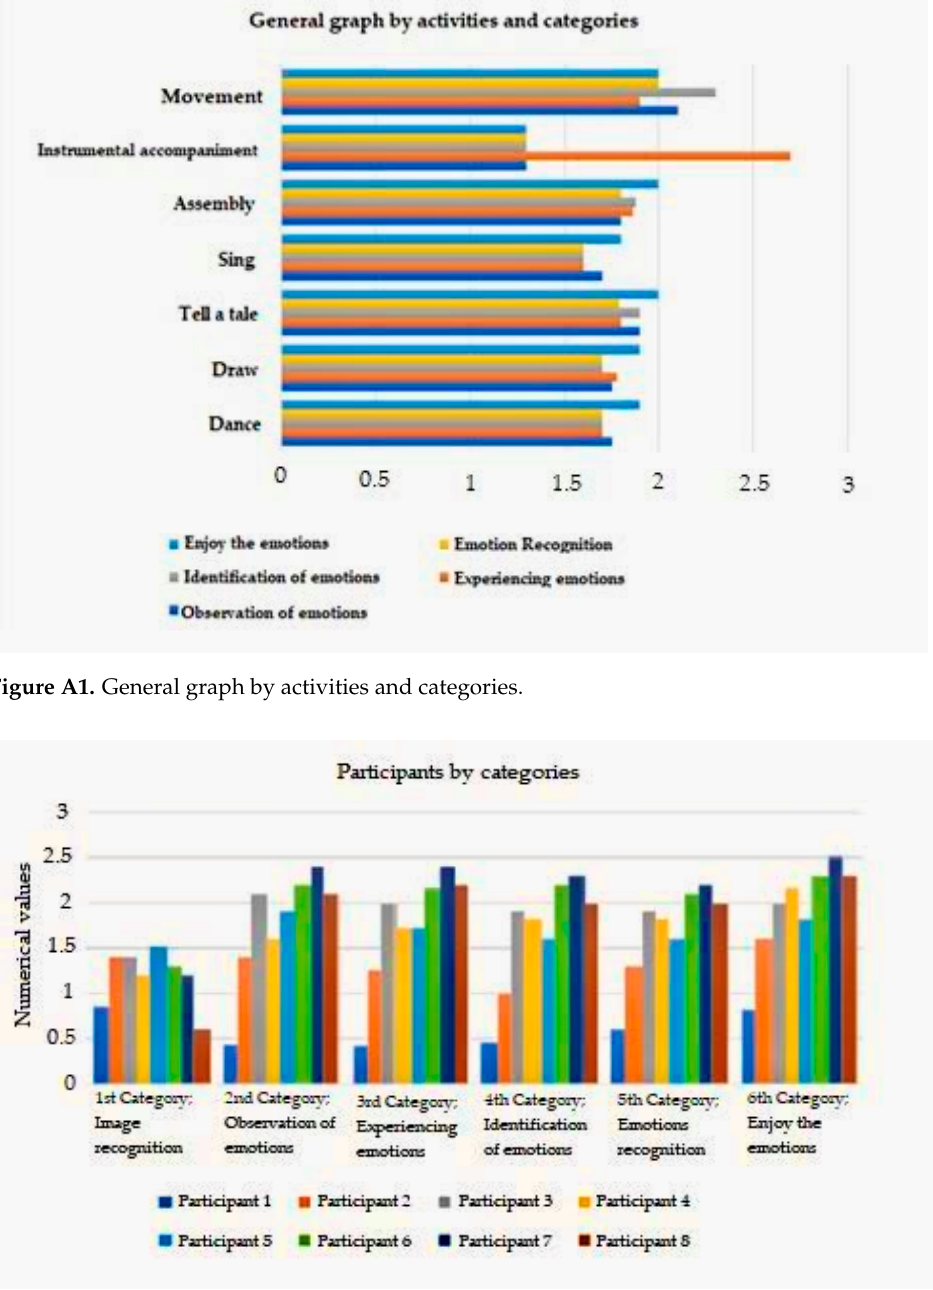
Figure A2. Participants by Figure A2 . Participants by categories.